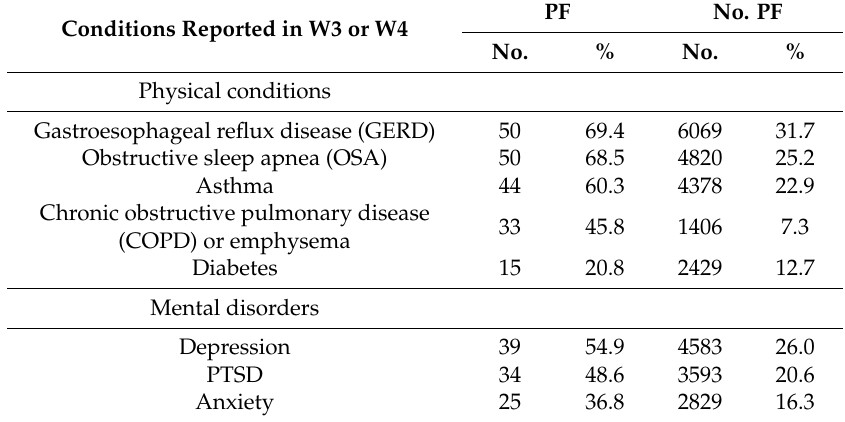
Table 4. Distribution of comorbidity by self-reported physician-diagnosed pulmonary fibrosis (PF) status